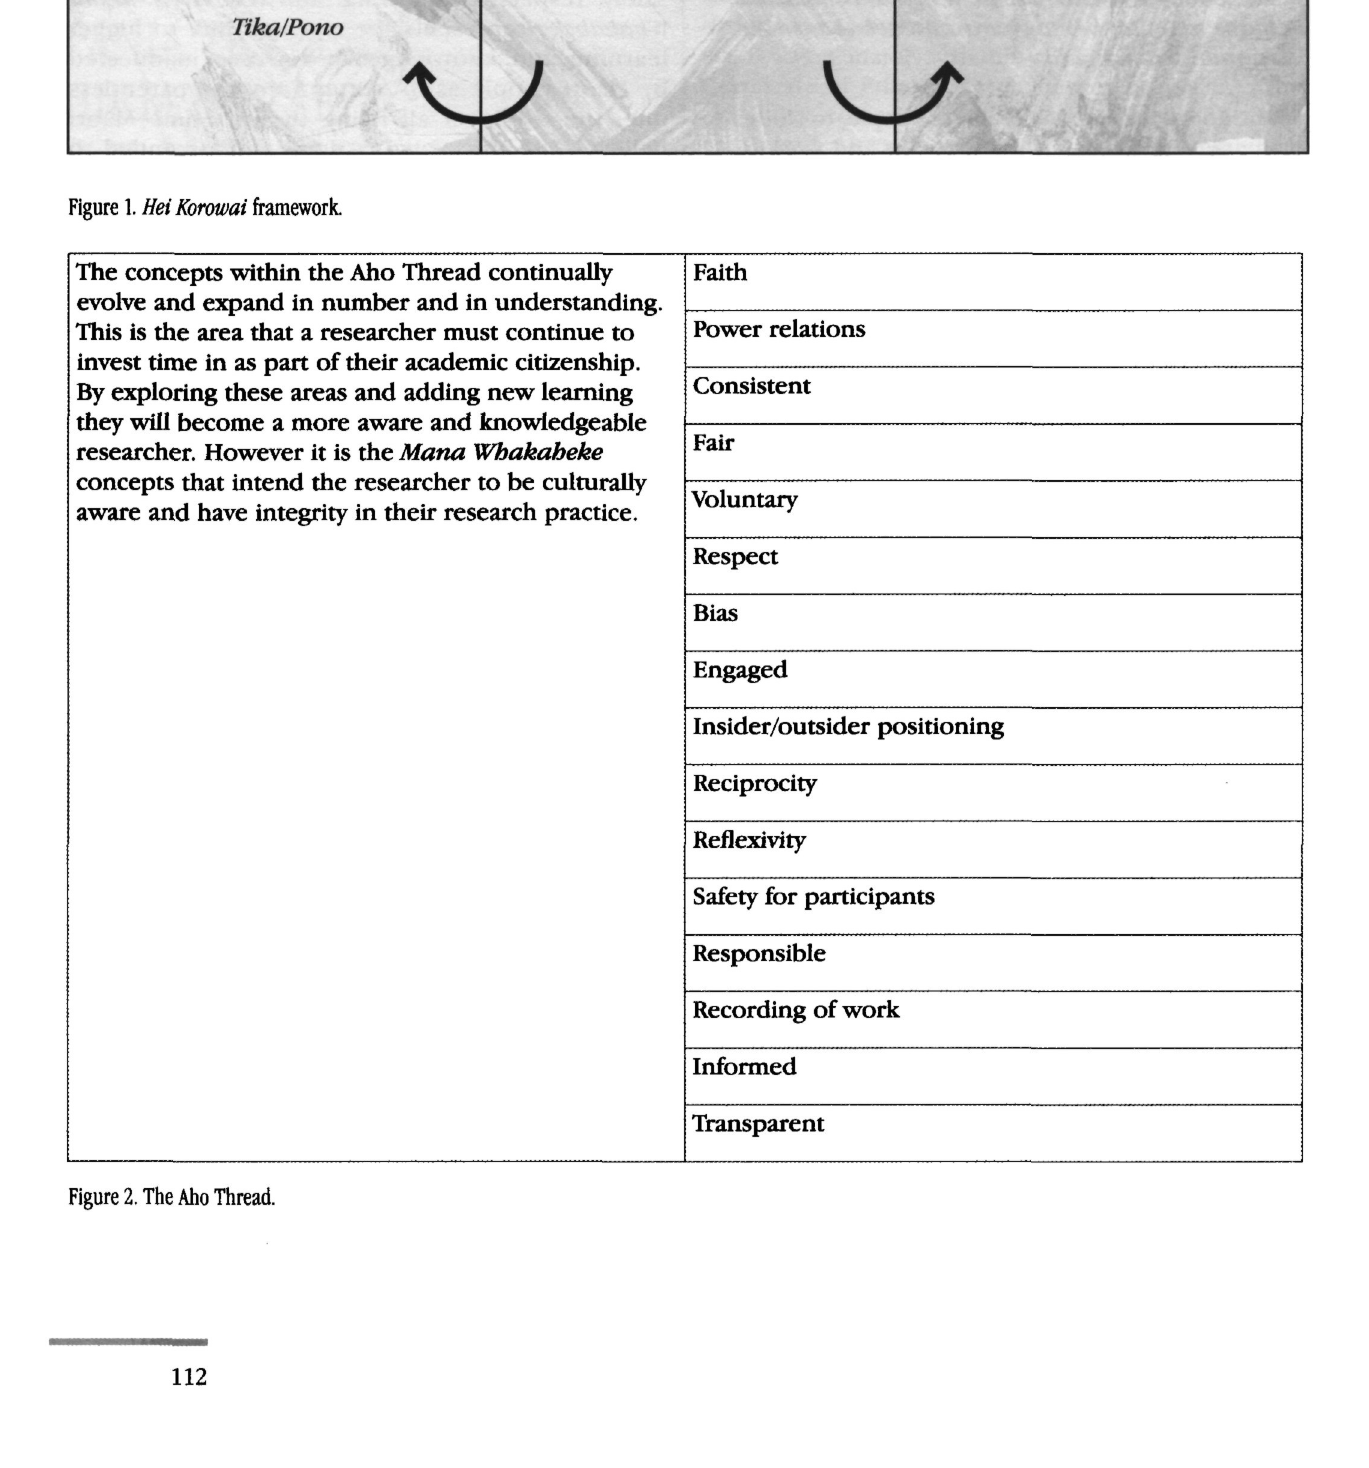
Figure 2. The Aho